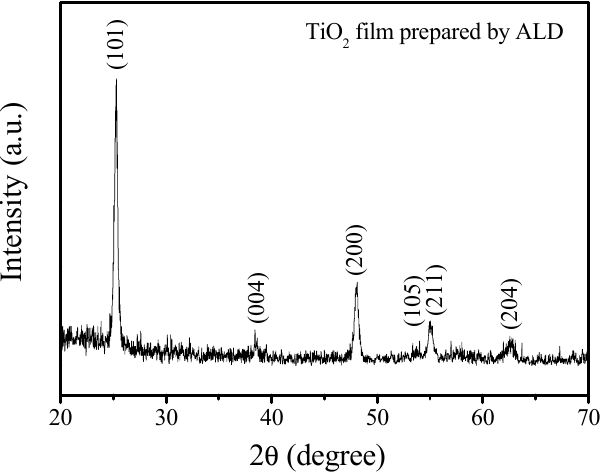
Figure 5. The XRD diffraction pattern of the TiO 2 thin film prepared by ALD. Hall measurement is used to confirm the type of metal oxide semiconductor material.